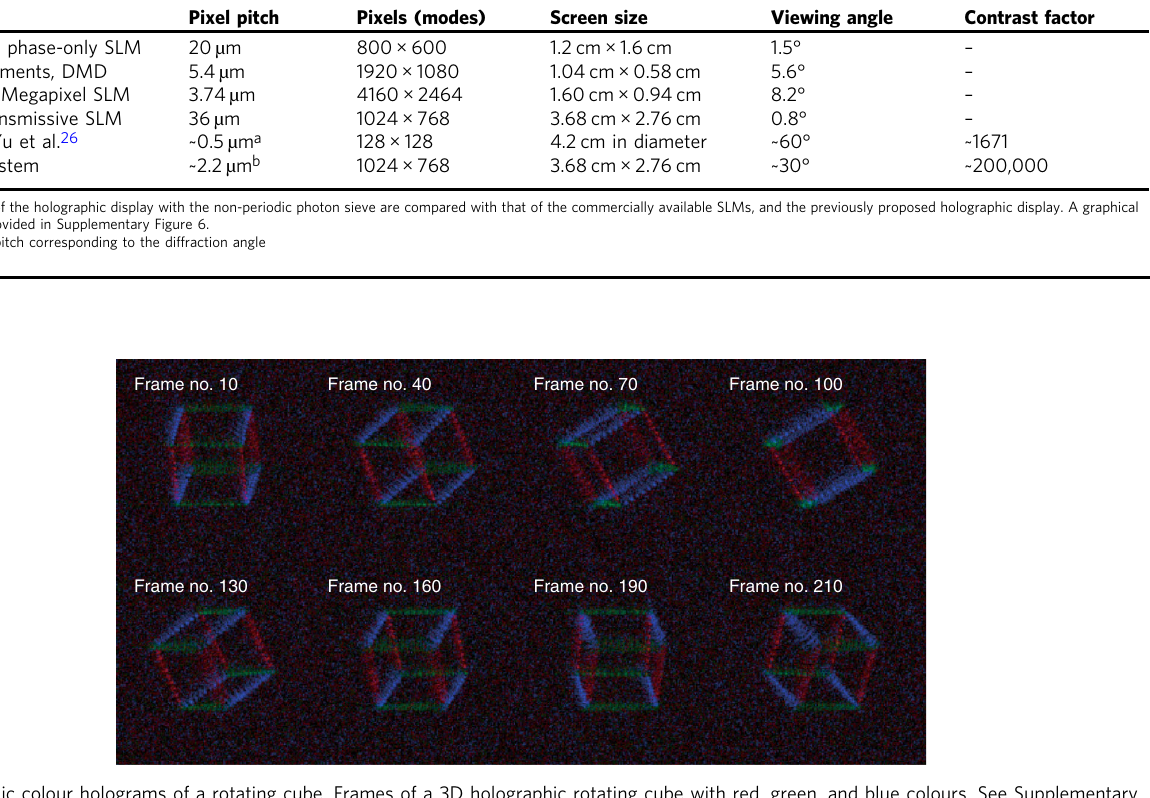
Fig. 4 Dynamic colour holograms of a rotating cube. Frames of a 3D holographic rotating cube with red, green, and blue colours. See Supplementary Movie 1 for the full set of